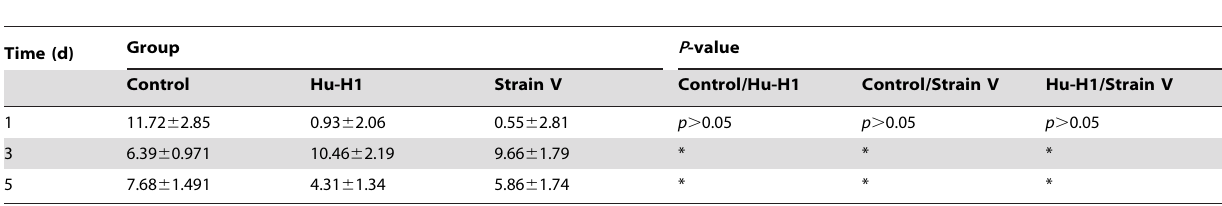
Table 3. Apoptotic cell counts at various time points (mean 6 s, n= 3).